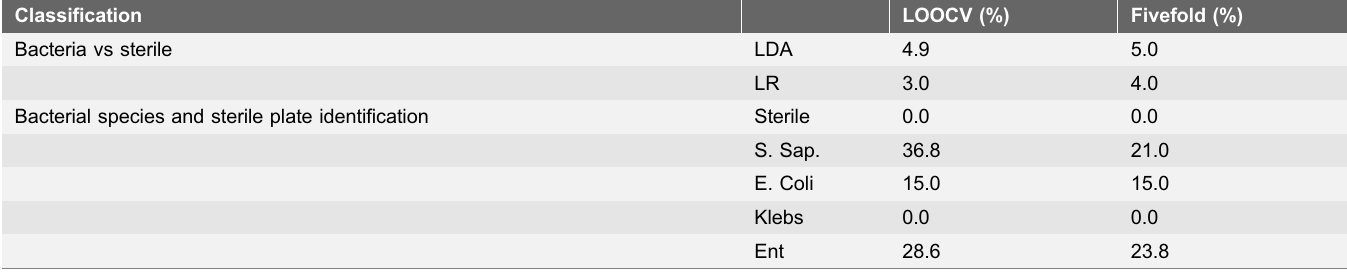
Table 4. Misclassification rates for classification of sterile vs bacteria and identification of bacterial species and sterile plate.